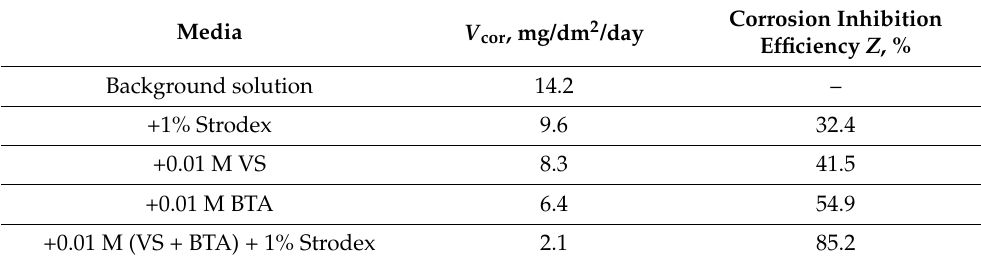
Corrosion Inhibition Efficiency Z , %